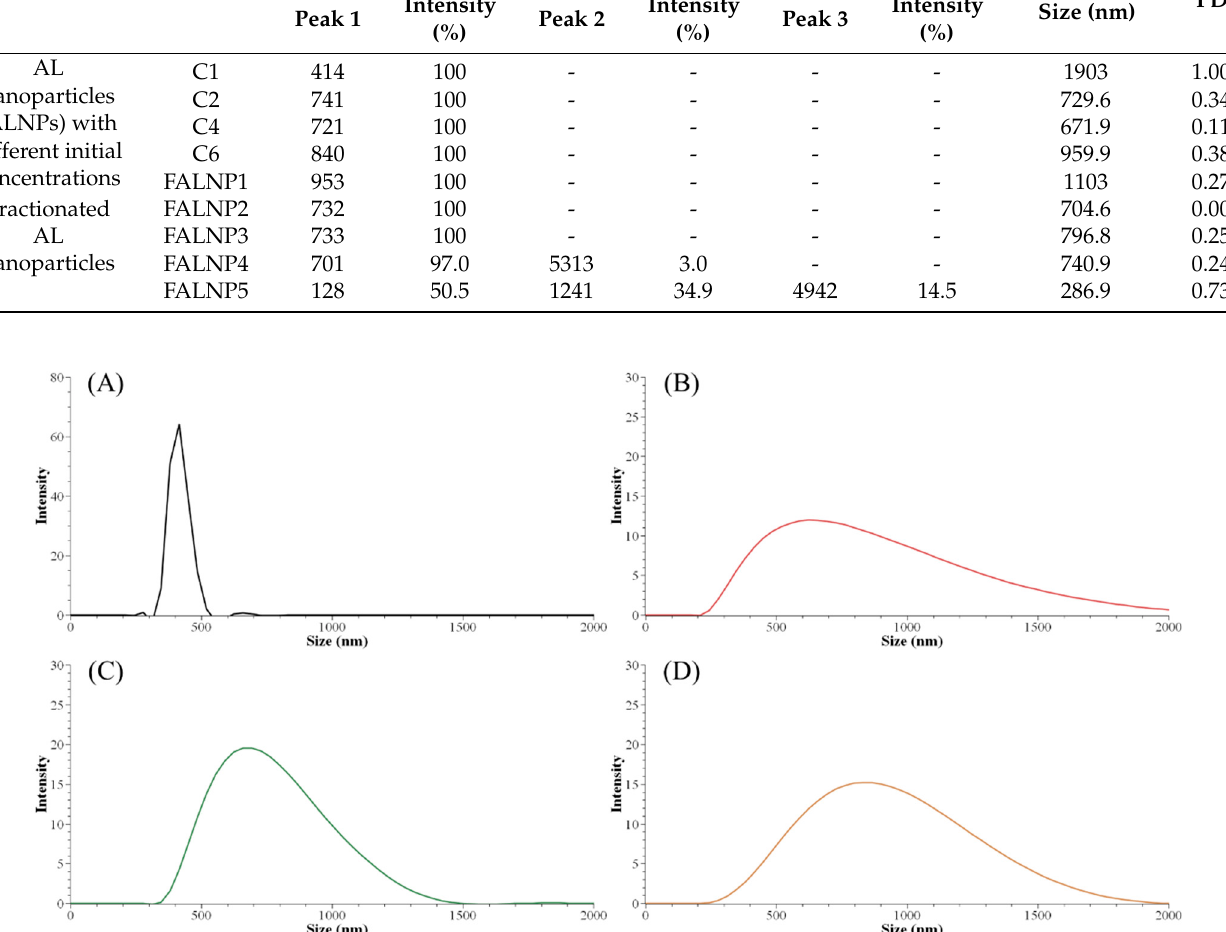
Figure 1. Particle size distribution graph of ALNPs with different initial concentrations. ( A ) ALNP-C1, ( B ) ALNP-C2, ( C ) ALNP-C4, and ( D ) ALNP-C6.